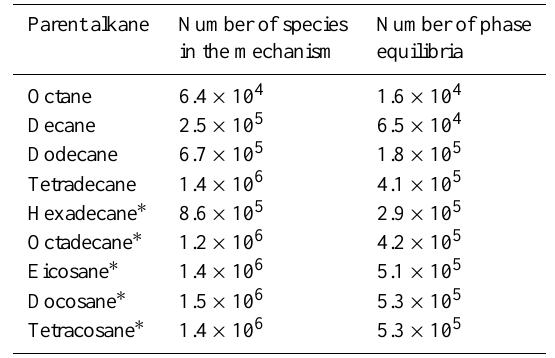
Table 1. Number of species considered in the gas phase oxidation mechanism generated with GECKO-A and number of non-radical species for which gas/aerosol equilibrium is accounted.